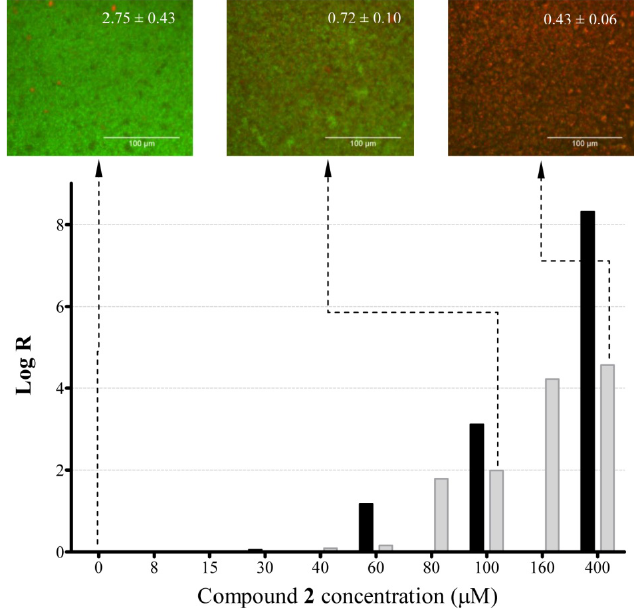
Figure 1. Killing anti-biofilm efficacy of compound 2 measured using Log Reduction (Log R), prior to biofilm formation (black bars) or post-biofilm formation (grey bars). As an insert, fluorescence microscopy images of 18 h S. aureus biofilms treated (or not) with 2 are shown. Fluorescence signal (G/R fluorescence ratios) calculated on replicate wells, are shown in each